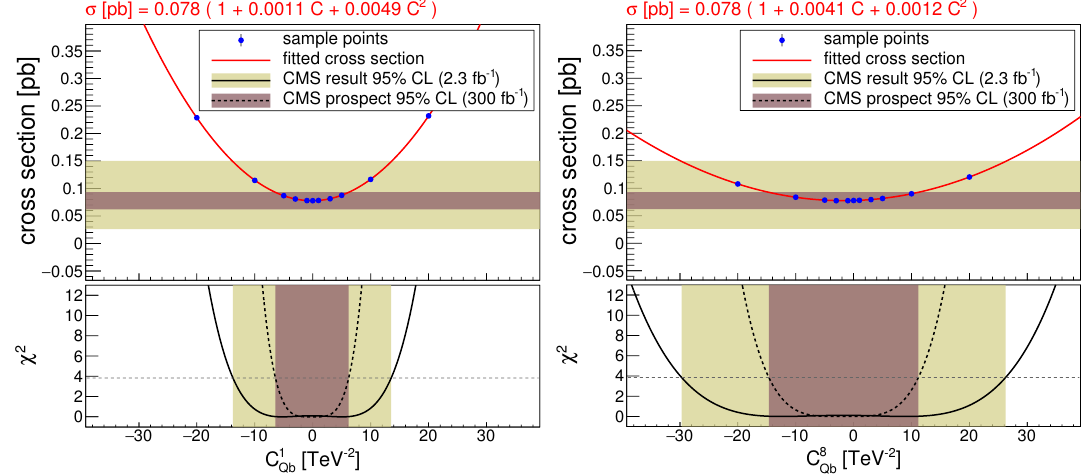
Figure 3 . Limits at 95% CL on C 1 line, light brown area) and prospects for 300 fb (cid:0) 1 (dashed line, dark brown